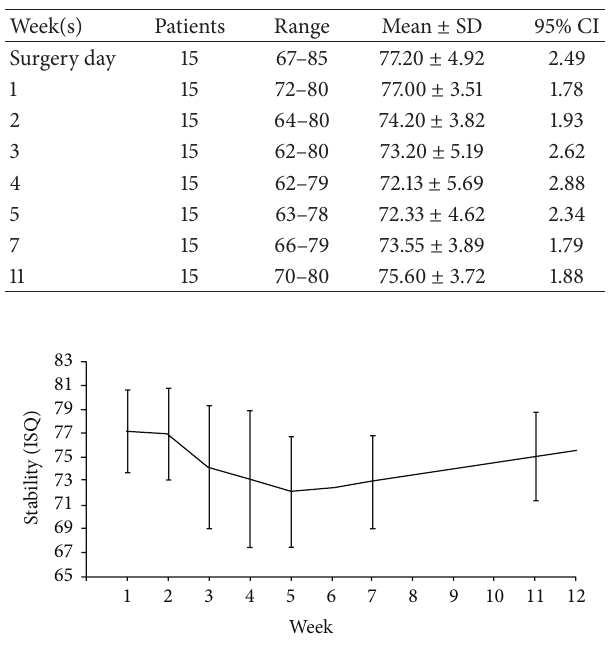
Figure 2: Illustration of the alternations of the mean implant stability values using resonance frequency